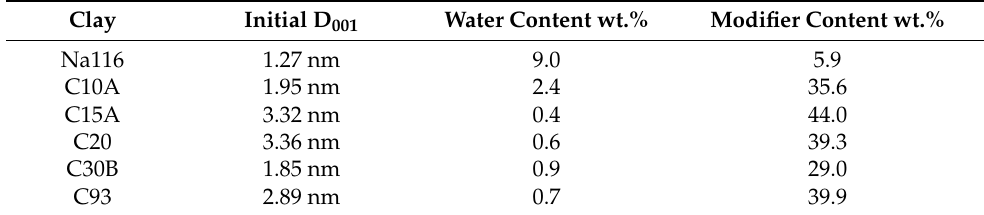
Table 2. Data from X-ray diffraction (XRD) and DSC-TGA characterization. Clay Initial D 001 Water Content